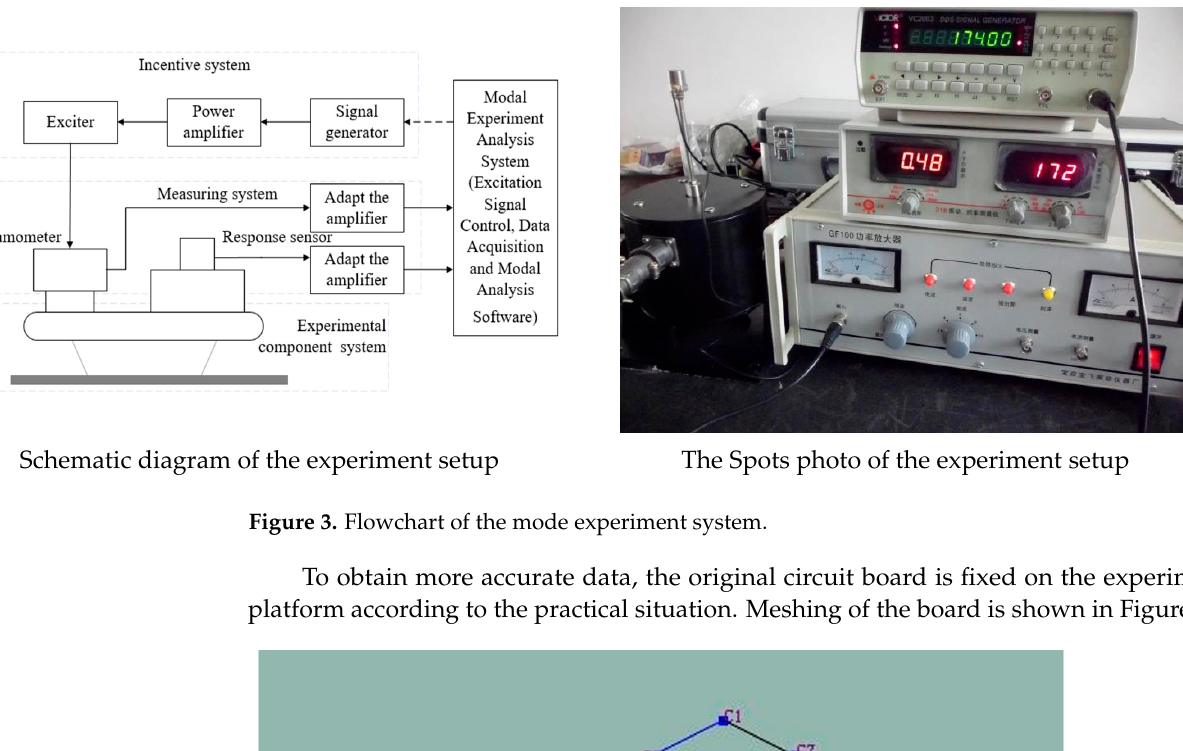
Figure 4. Meshing during the mode experiment.